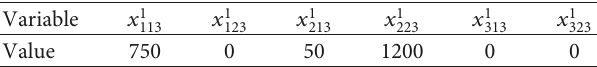
Table 11: The amounts of transported goods to supplementary origins B1 and B2.